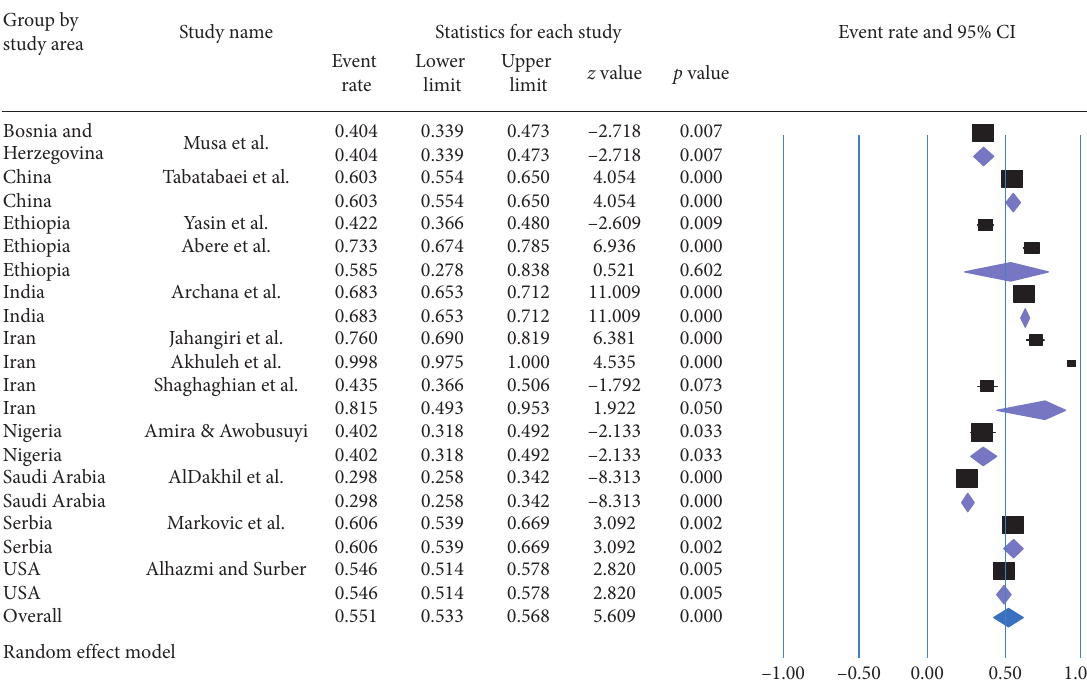
Figure 3: Forest plot shows the subgroup analysis of pooled prevalence of career time occupational exposure to needle stick injury based on the study